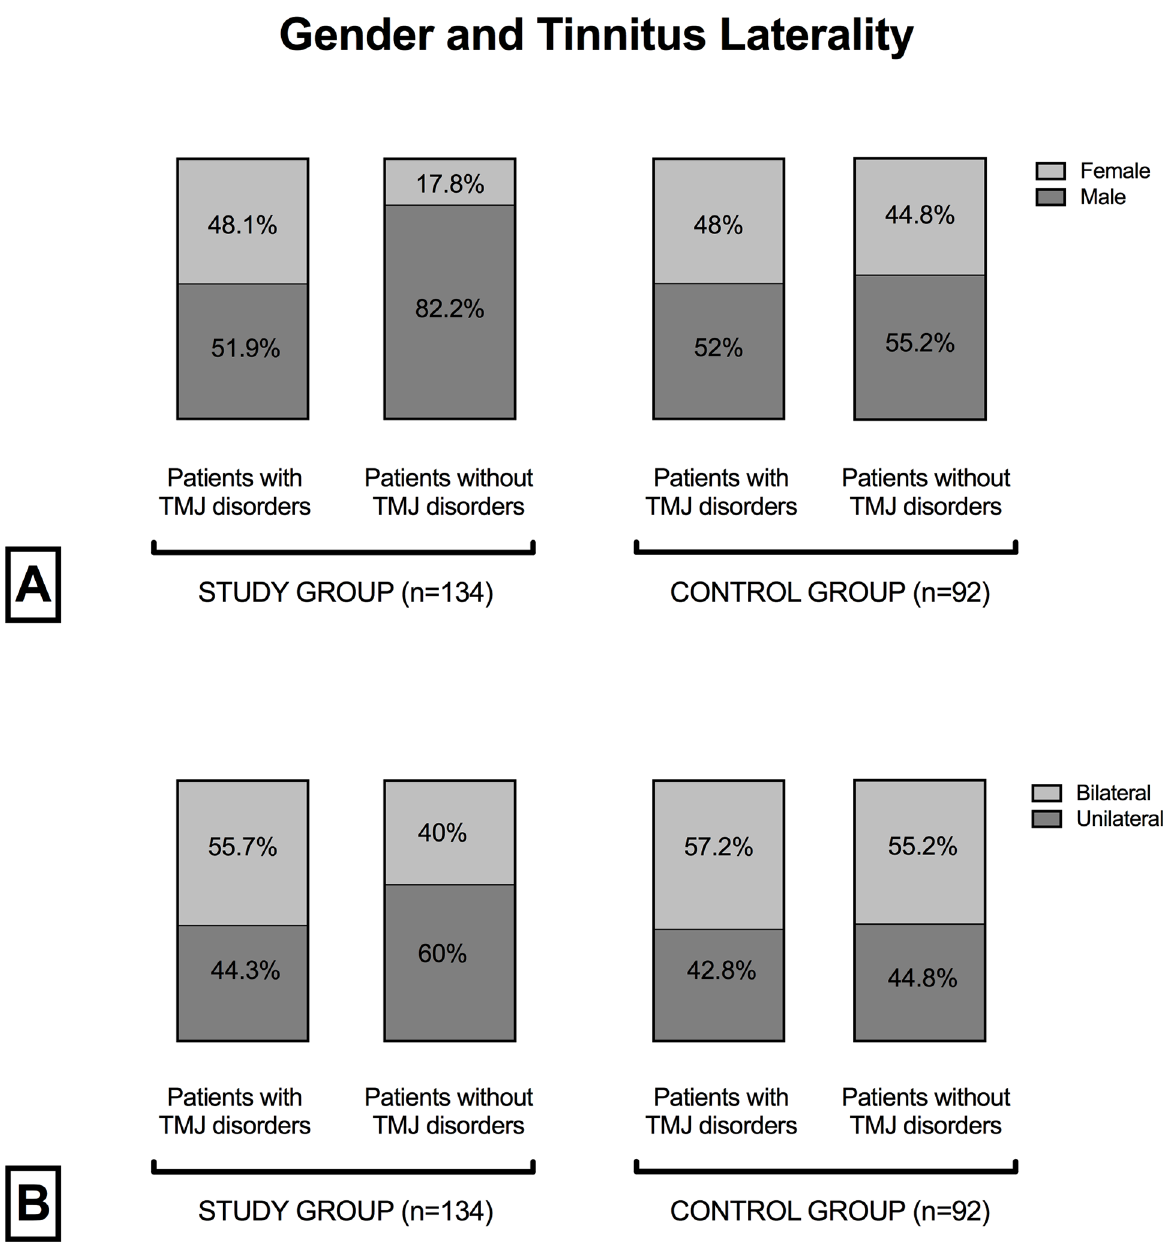
Fig 3. Relative proportions for gender and tinnitus laterality within groups. Comparison of relative proportion of (A) gender and (B) tinnitus laterality in dependence from a diagnosis of temporomandibular joint (TMJ) disorder in the study and control groups.